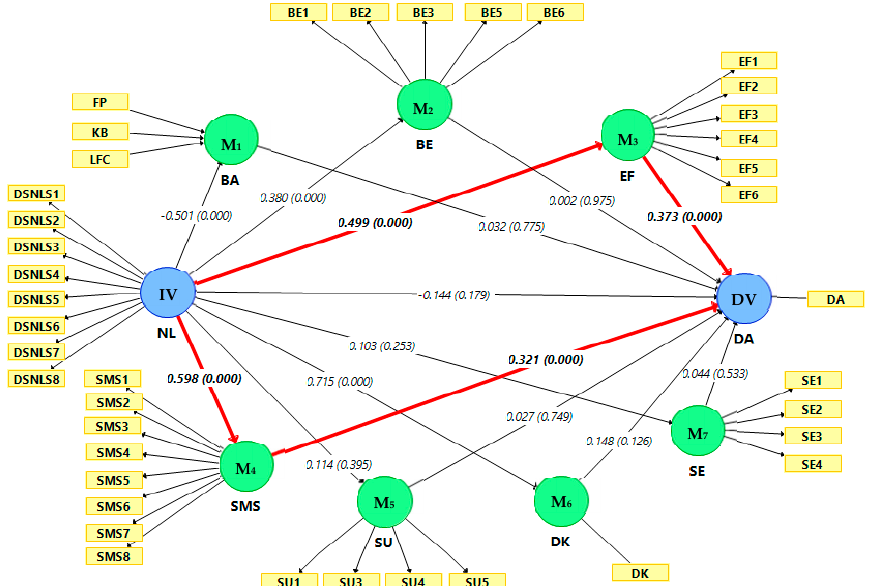
Figure 1. Bootstrapping result for mediation analysis (5000 resamples and 2-tailed). The figure shows the hypothesised mediation paths connecting nutrition literacy to dietary adherence in HD patients. Significant mediation paths are highlighted by red bold lines. Data are presented as path coefficient